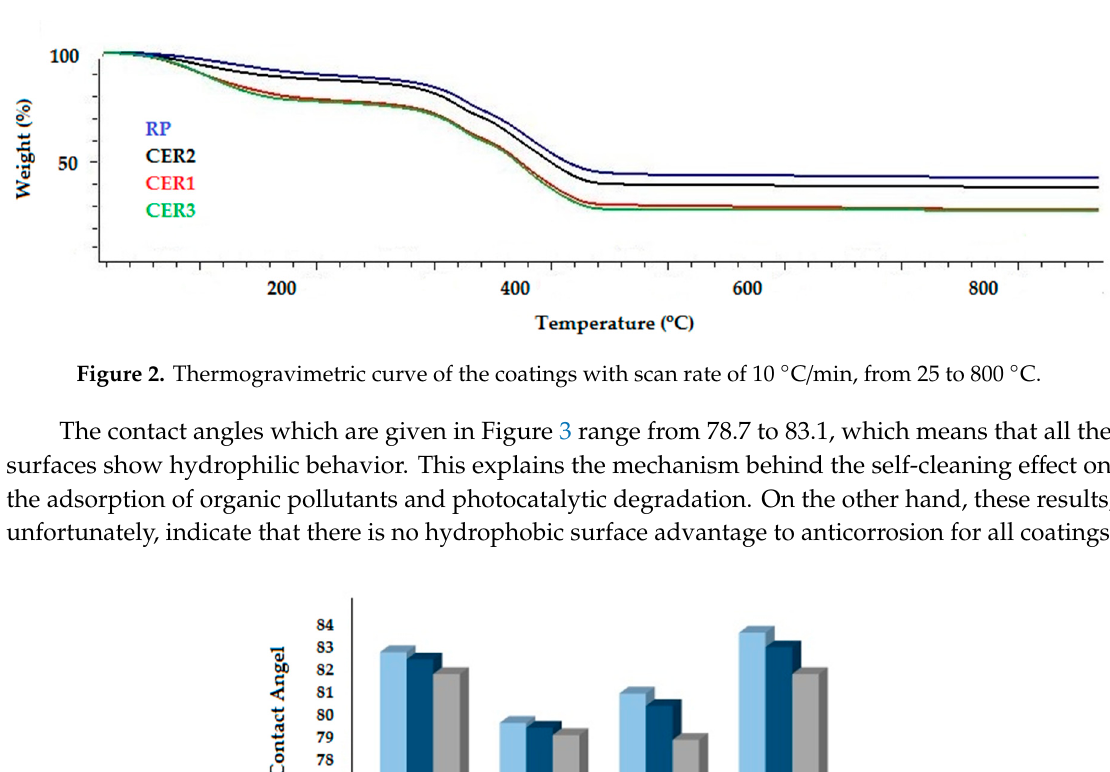
Figure 3. Contact angle values of coatings with water at different contact time.